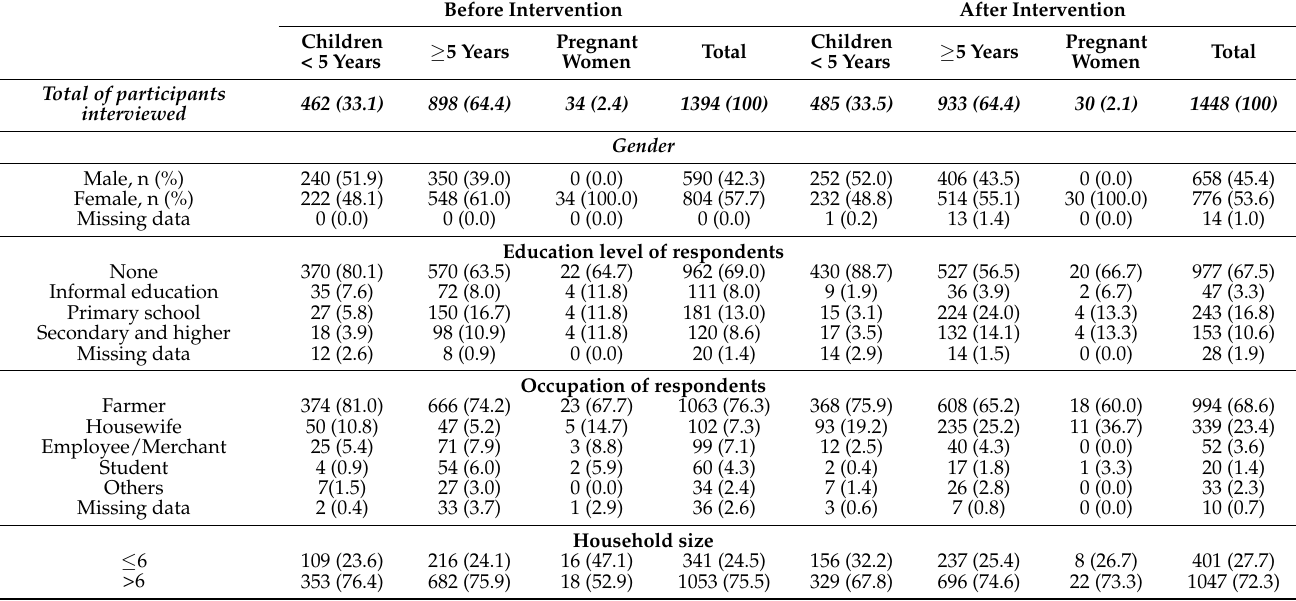
Table 3. Sociodemographic characteristics of study participants during the household surveys.